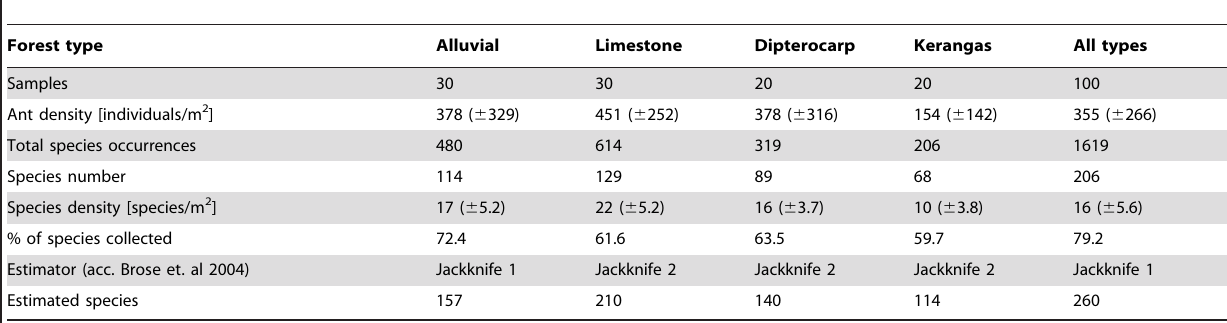
Table 1. Sample parameters, collected and estimated numbers of ant species in the four forest types of Gunung Mulu National